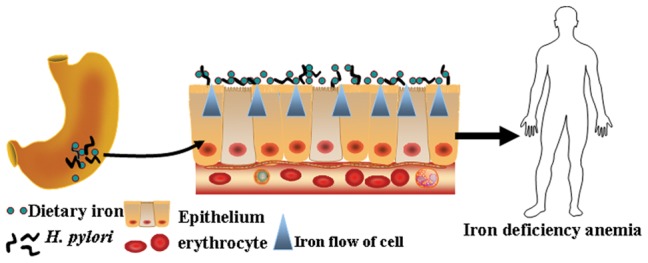
Diagram of the novel mechanism for iron deficiency anemia caused by H. pylori.
In case of H.Pylori infection, the demand for iron element of Helicobacter is increased. H.Pylori colonized in stomach competitively absorbs iron with host. The dietary iron is continuously absorbed by H.Pylori. At the same time, the iron within the host epithelial cells is flowed out and absorbed by H.Pyloris gathered on the surface of epithelial, leading to iron insufficient intake in host.